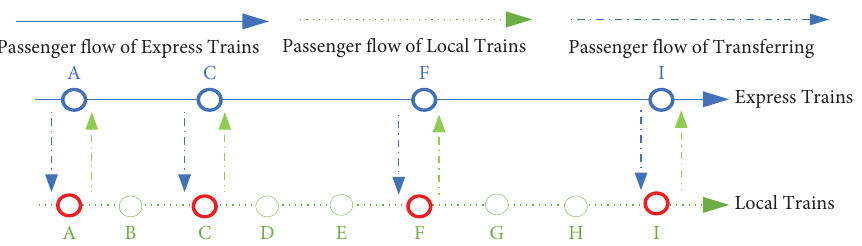
Figure 3: Express and local train operation mode of the suburban line of rail